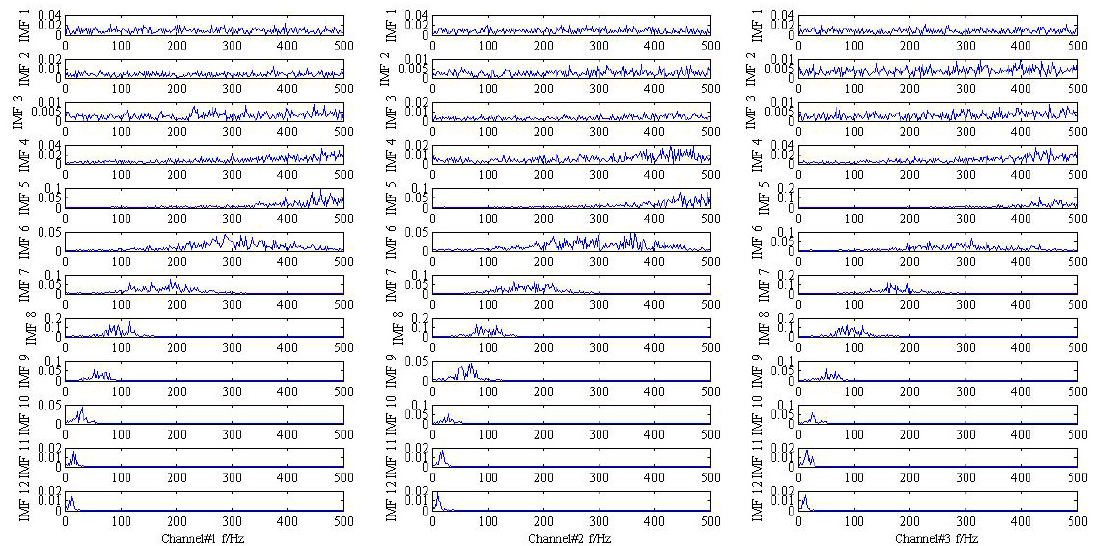
Figure 10. The result provided by MEMD in frequency domain.